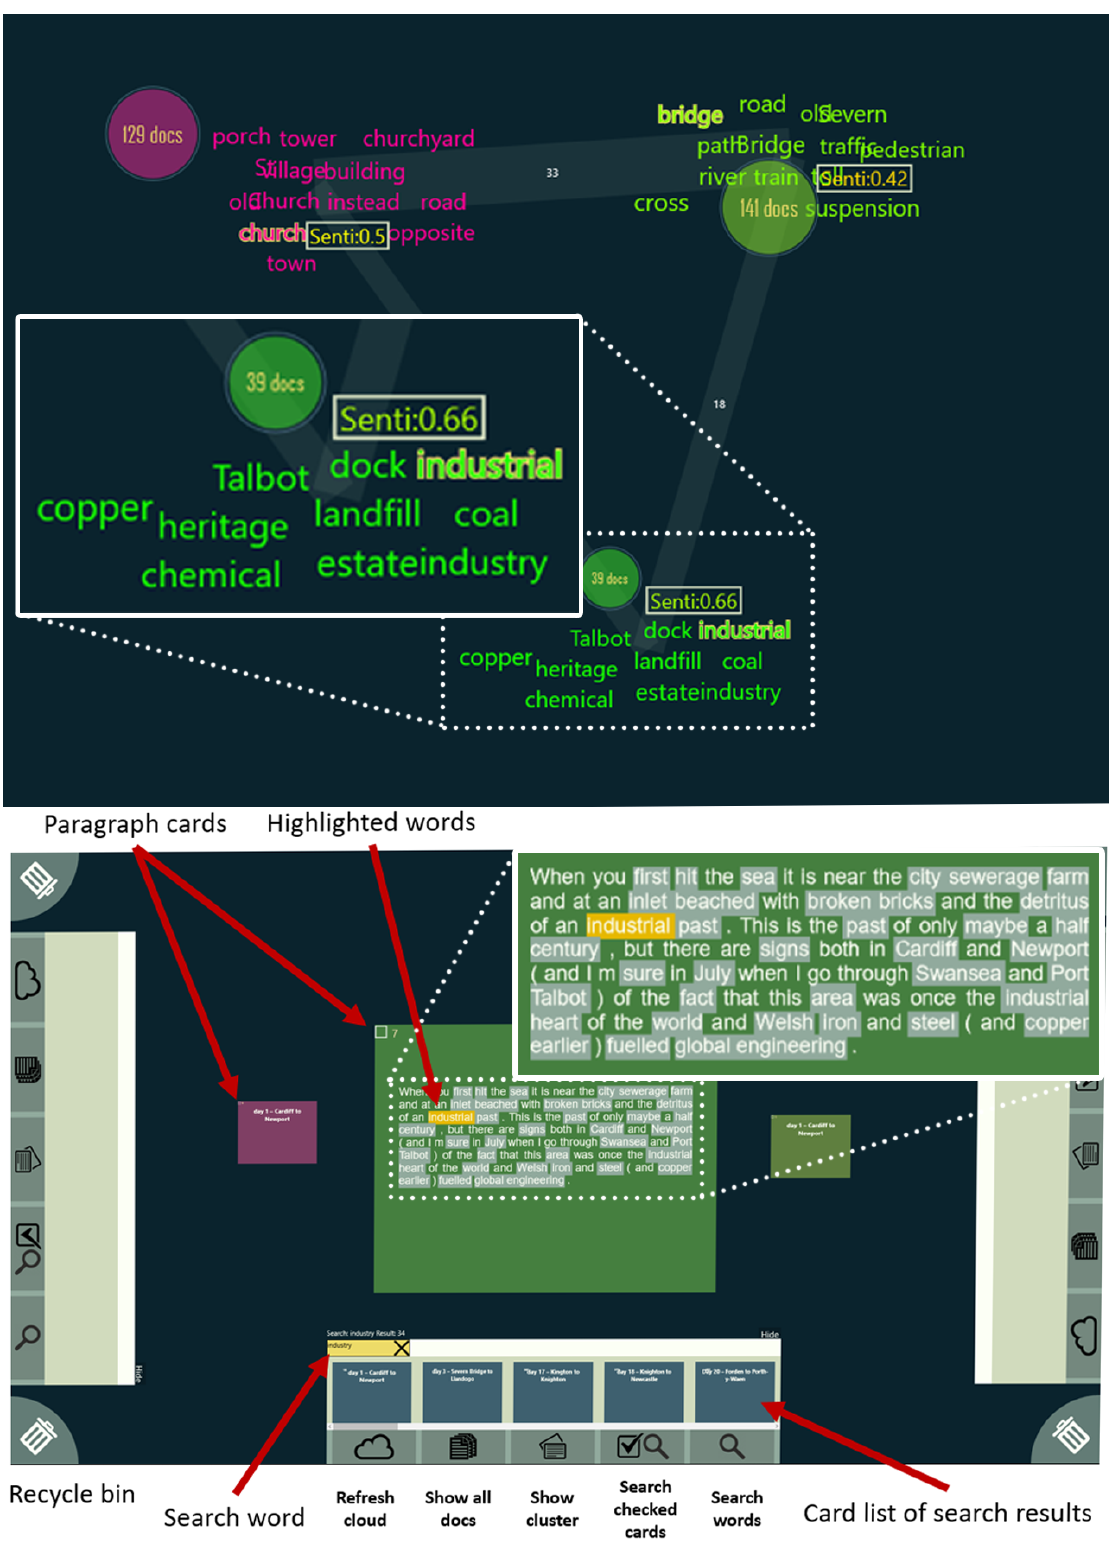
Figure 5. ( Top ) Connected word cloud visualizing the reorganization of blogs. The word cloud abstracts paragraph groups and connect topics to inspire new perspectives. ( Bottom ) Touch interface runs on the tabletop display. The three paragraph cards generate three word clouds in the vertical display. The card in middle is a paragraph about an industrial relic, and its corresponding word cloud is shown in the zoomed frame in the top